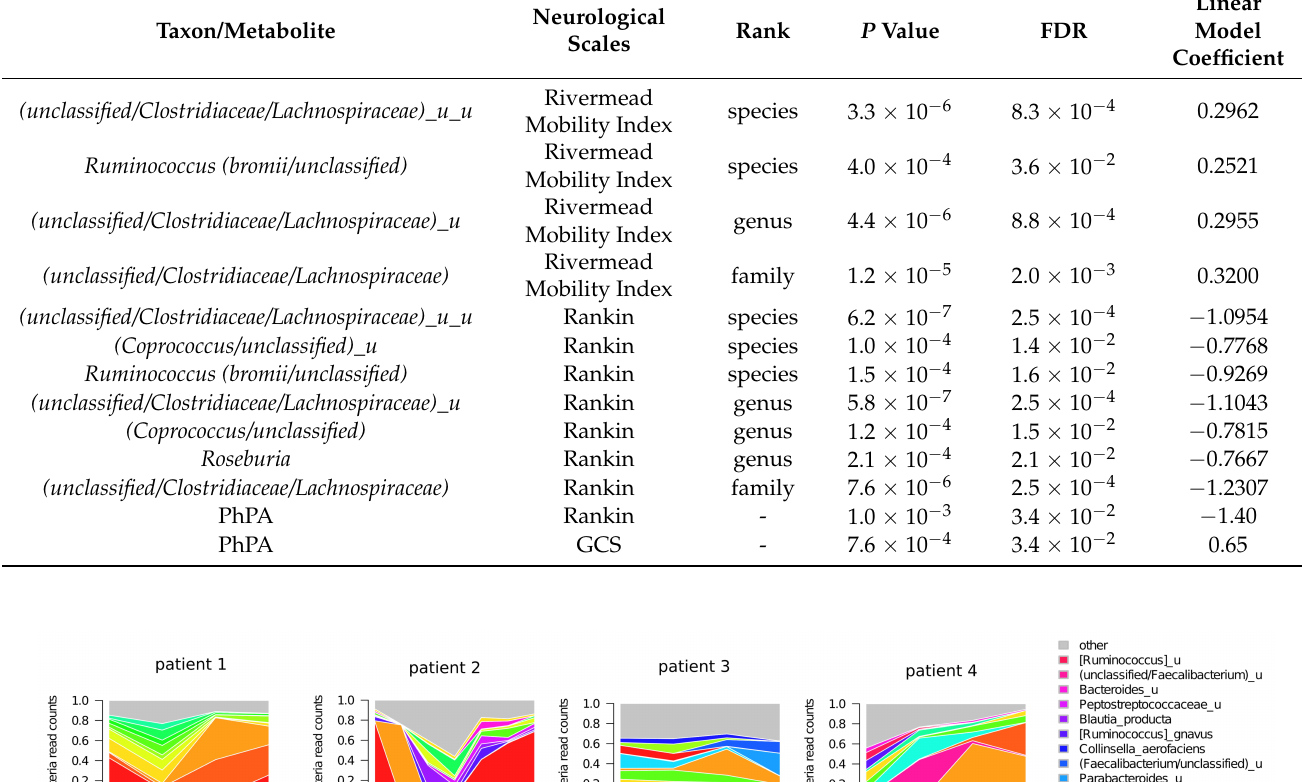
Table 2. Significant associations of the microbiome and metabolite profiles with neurological scales.